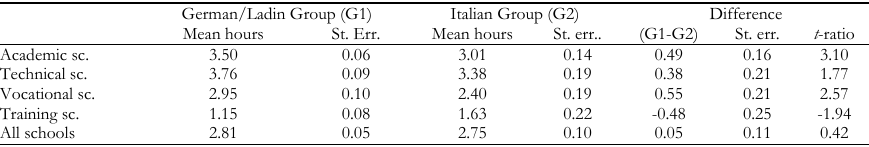
Mean hours of science in Bolzano by school type and language group German/Ladin Group (G1) Italian Group (G2) Difference Mean hours St. Err. Mean hours St.